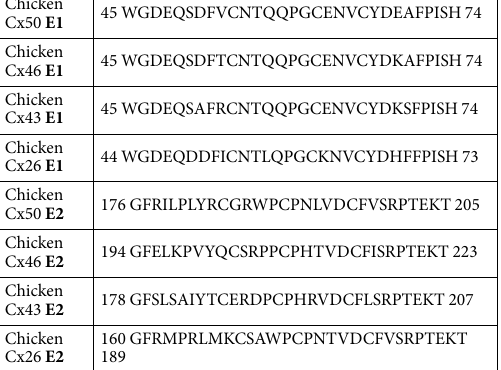
Table 1. Comparison of chicken Cx50E1 and E2 domains with chicken Cx43, Cx46 and